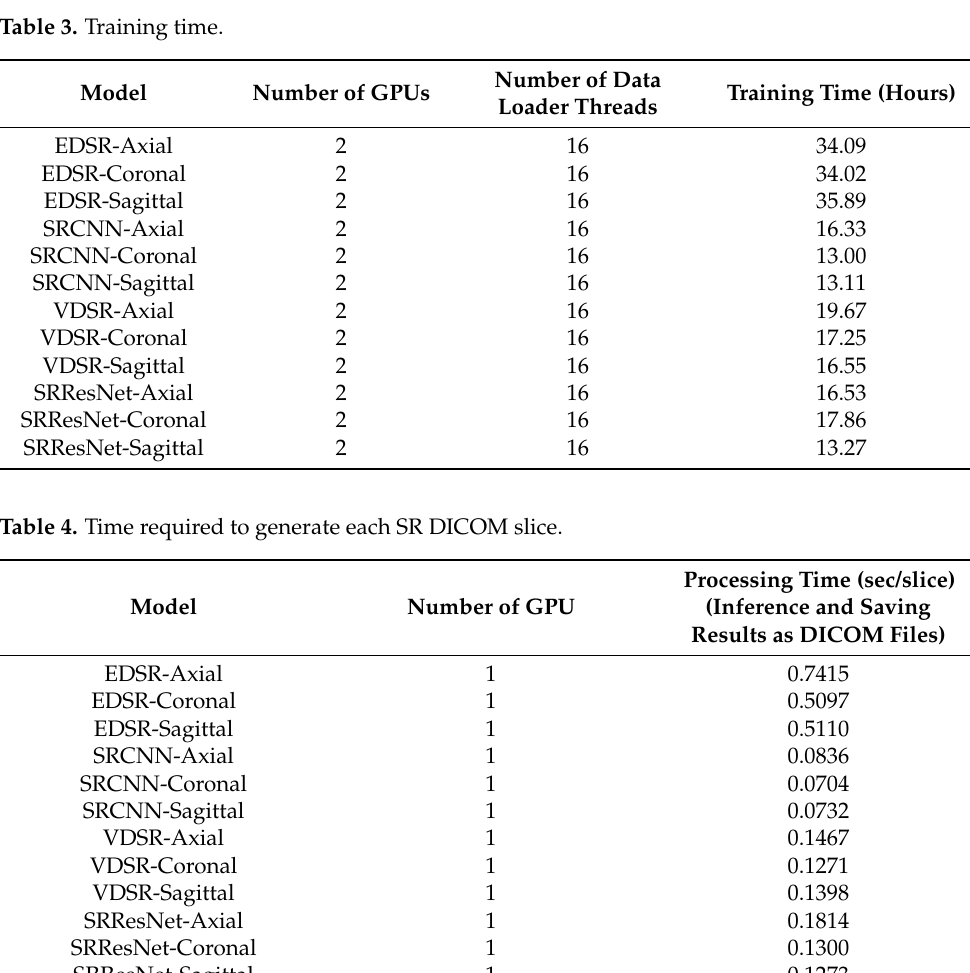
Table 3. Training time.